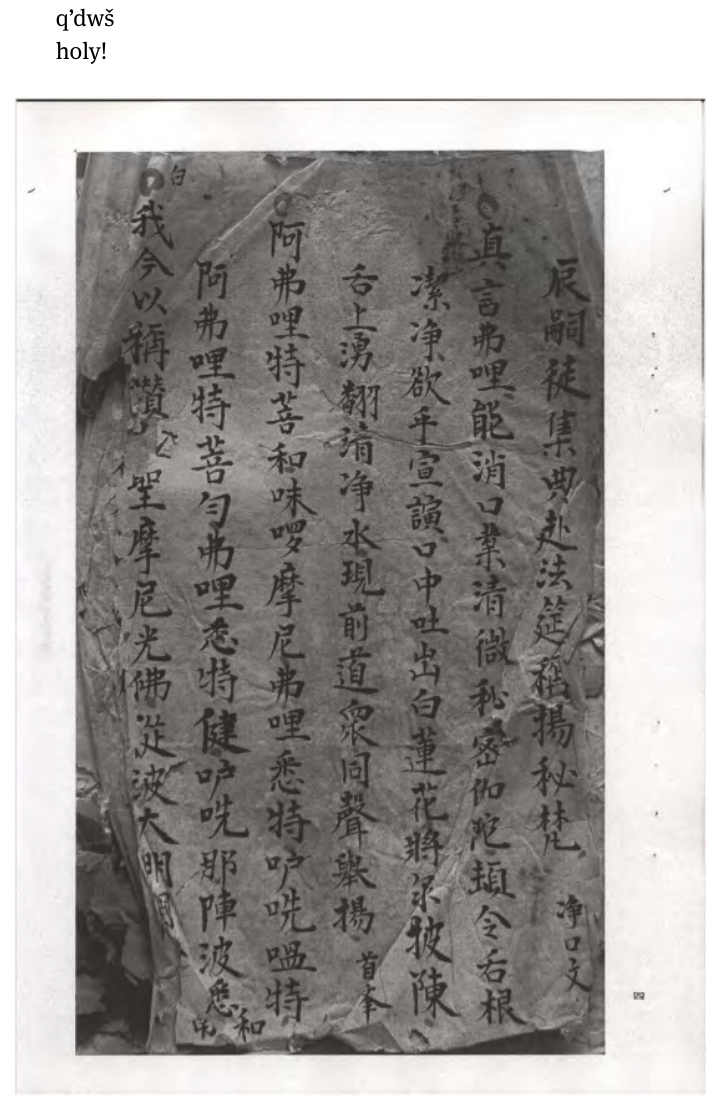
Plate 2: page 4 of XQK ( Ritual Manual for the Celebration of the Birthday of Ancestor of Promoting Well-being ) 39 义 in Ji Jianchen, Xiapu ,